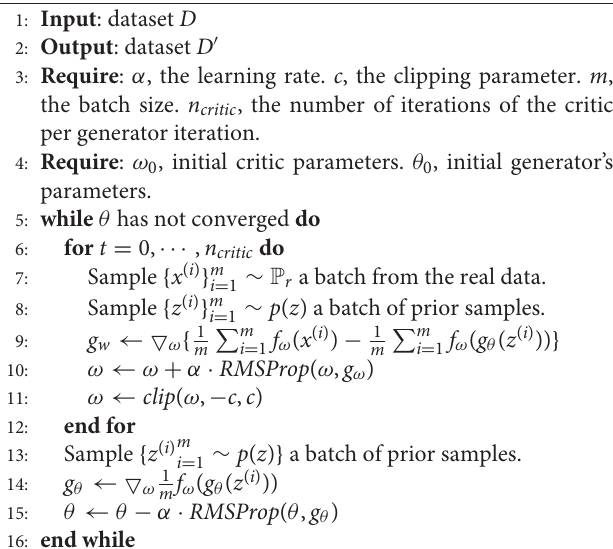
Algorithm 1: Algorithm of WGAN. α = 0.00005, c = 0.01, m = 64, n critic =